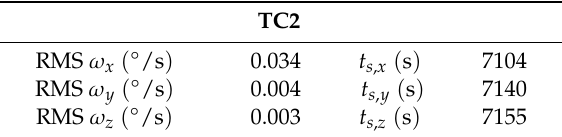
Table 11. Root Mean Square of angular rates estimation error and settling times for Hardware-in-the-Loop simulation of Test Case 1.